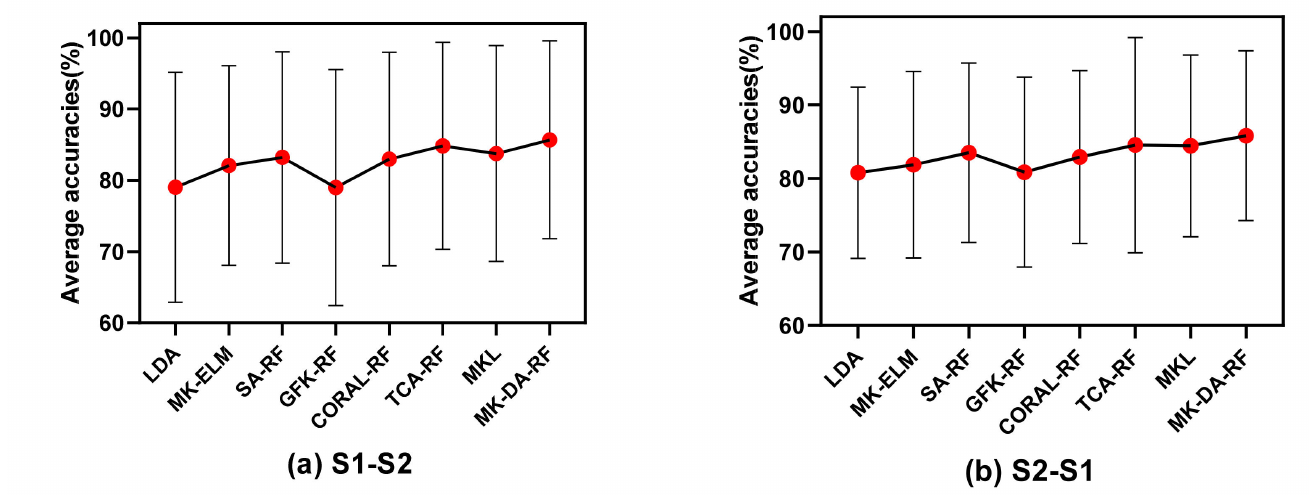
Figure 9. The results of the different distribution adaptation methods for the NBI group.